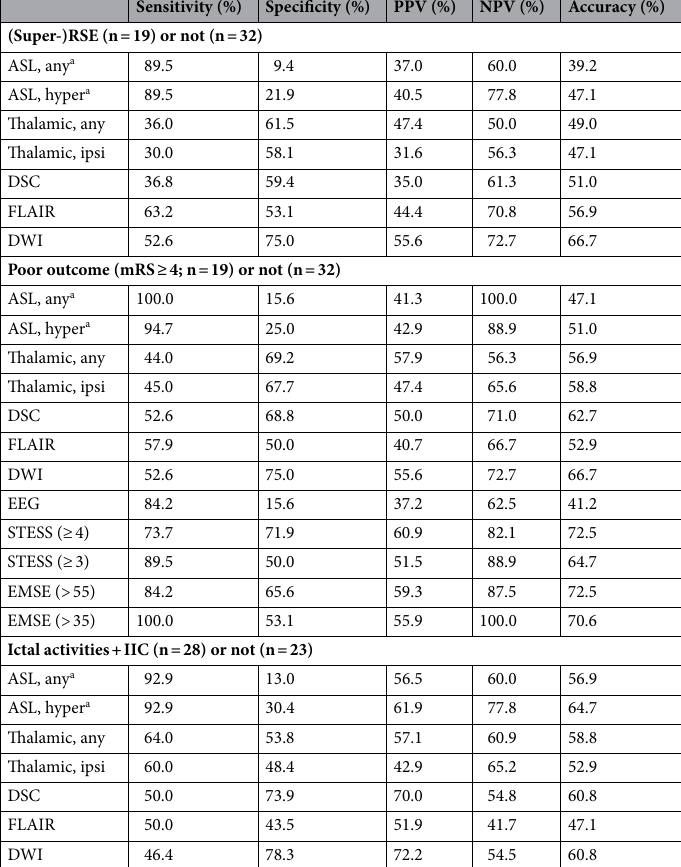
Table 3. Sensitivity, specificity, PPV, NPV, and accuracy of each method with prognosis. a Any, any change including both hyper- and hypo-perfusion; hyper, only hyperperfusion. PPV positive predictive value, NPV negative predictive value, RSE refractory status epilepticus, ASL arterial spin labeling, DSC dynamic susceptibility contrast, FLAIR fluid attenuated inversion recovery, DWI diffusion weighted imaging, mRS modified Rankin Scale, EEG electroencephalography, STESS status epilepticus severity score, EMSE epidemiology-based mortality score in status epilepticus, IIC ictal-interictal